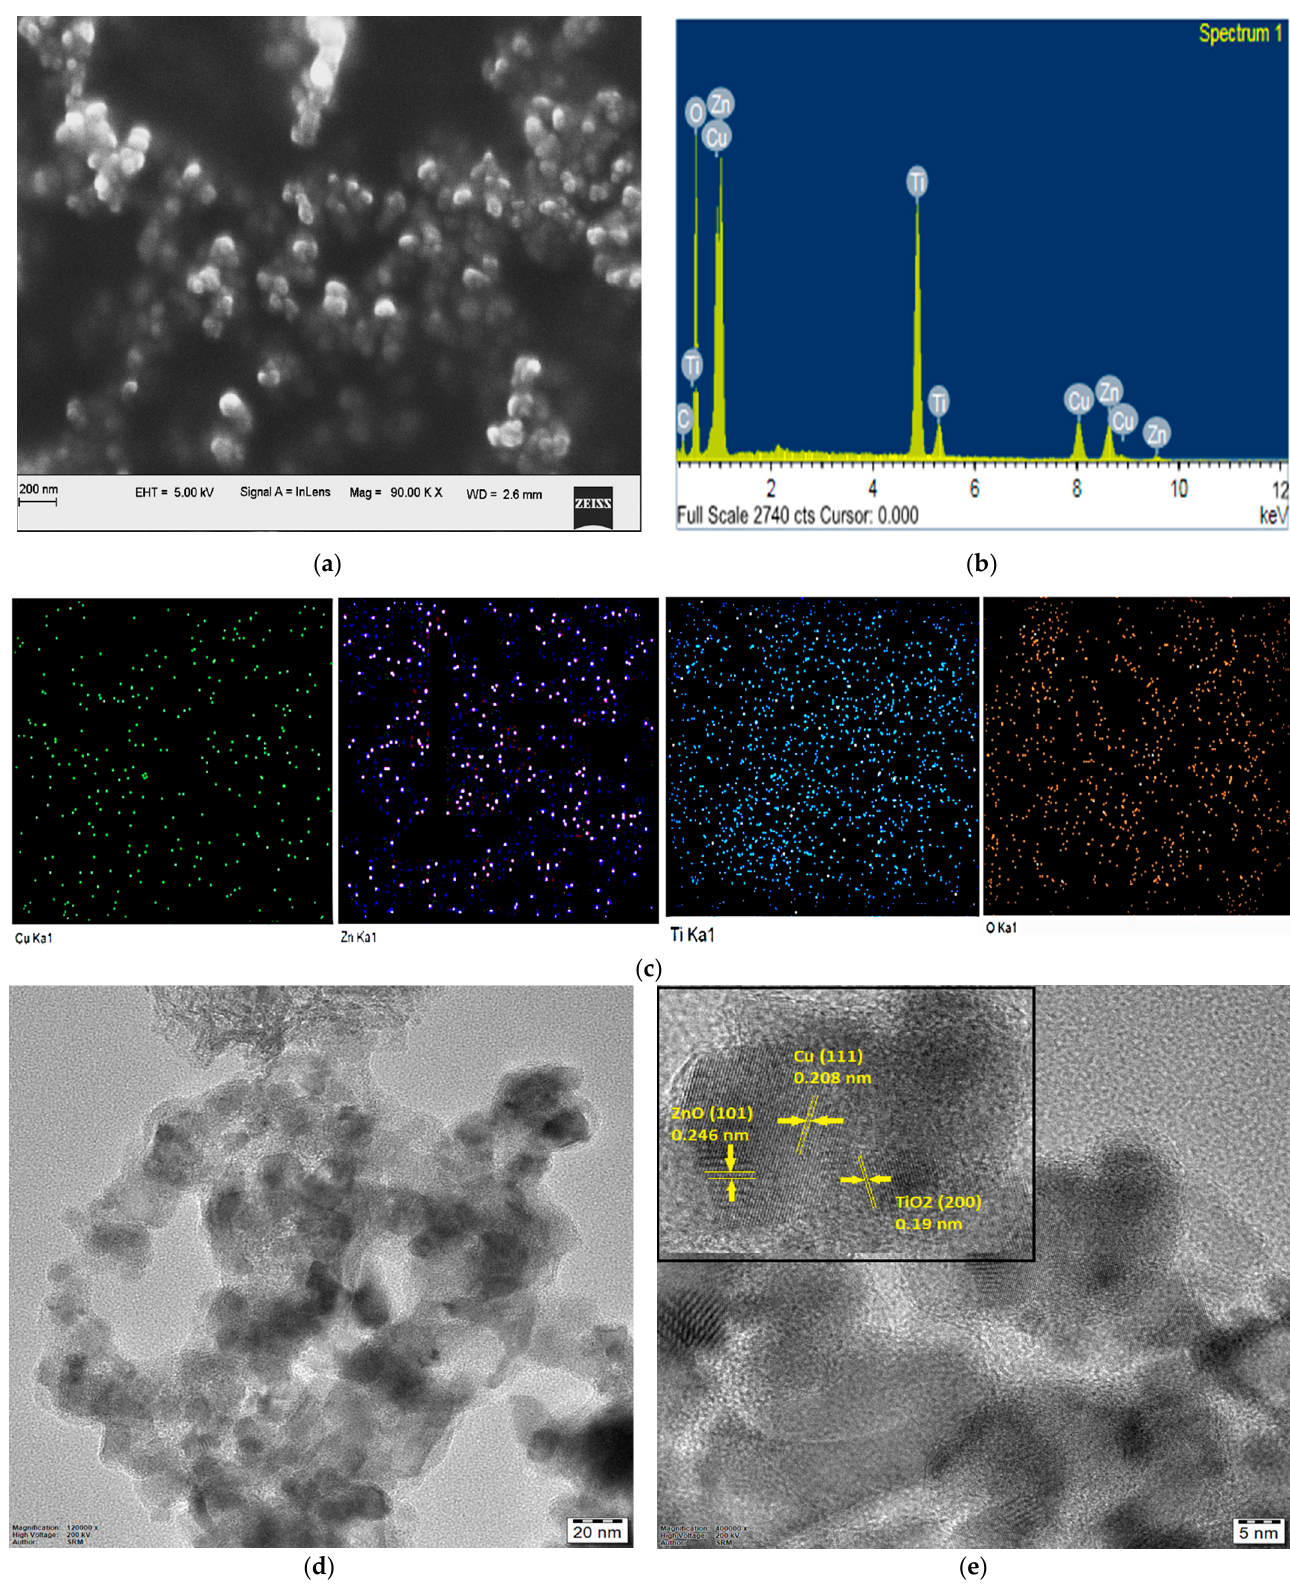
Figure 2. ( a ) FESEM image ( b ) EDX ( c ) Elemental mapping images ( d , e ) HRTEM images of Cu- ZnO/TiO 2 (CZT-2) nanocomposite photocatalyst. ZnO/TiO 2 (CZT-2) nanocomposite